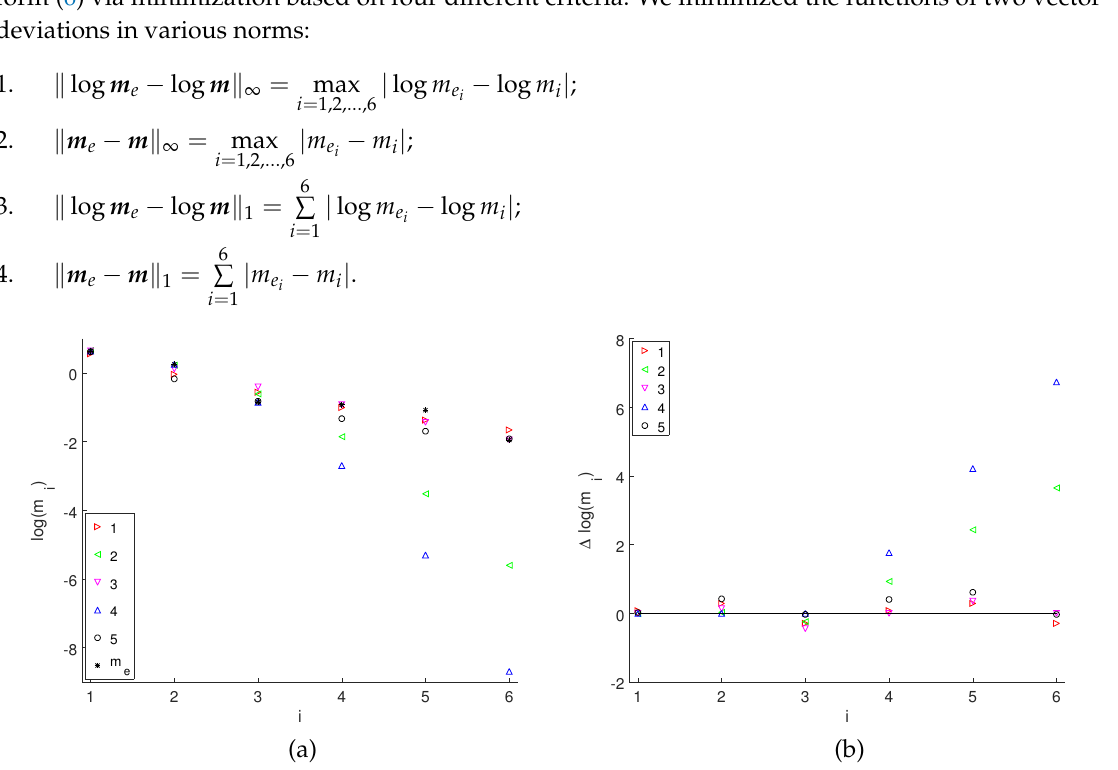
Figure 7. ( a ) theoretical values of the logarithms m i (asterisk * marks measured values) describing average values of 15-mm pipes; ( b ) deviations of theoretical logarithms of the values of m i from logarithms of the values m e obtained experimentally, i = 1, ..., 6 for criteria i